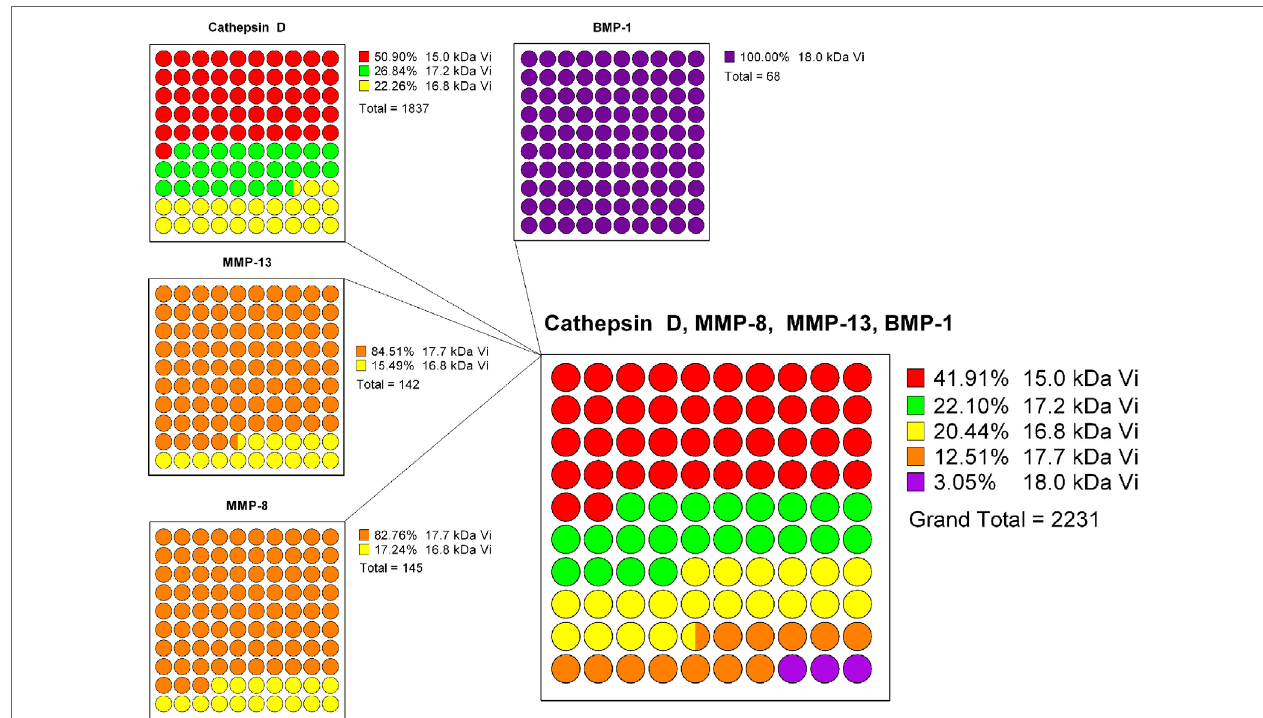
FigUre 2 | To estimate the composition of vasoinhibin isoforms, a projection based on the known prolactin-cleavage sites of vasoinhibin-generating enzymes (Cathepsin D, MMP-8/13, and BMP-1) and their calculated cleavage efficiency (8P-score) was performed. Cathepsin D generates the 15, the 17.2, and the 16.8 kDa vasoinhibin isoform, with the highest cleavage efficiency at the site generating the 15 kDa isoform. The 8P-scores of each Cathepsin D cleavage site were added and represented in parts of a whole graph. The same analysis was performed for MMP-13, MMP-8, and BMP-1. Finally, the percent representation of the cleavage efficiency of all enzymes and vasoinhibin isoforms was combined. It appears that, on the basis of the cleavage efficiency of vasoinhibin-generating enzymes, the 15 kDa vasoinhibin isoform would be most abundant (41.91%), followed by the 17.2 kDa (22.10%), the 16.8 kDa (20.44%), the 17.7 kDa (12.51%), and the 18 kDa (3.05%)